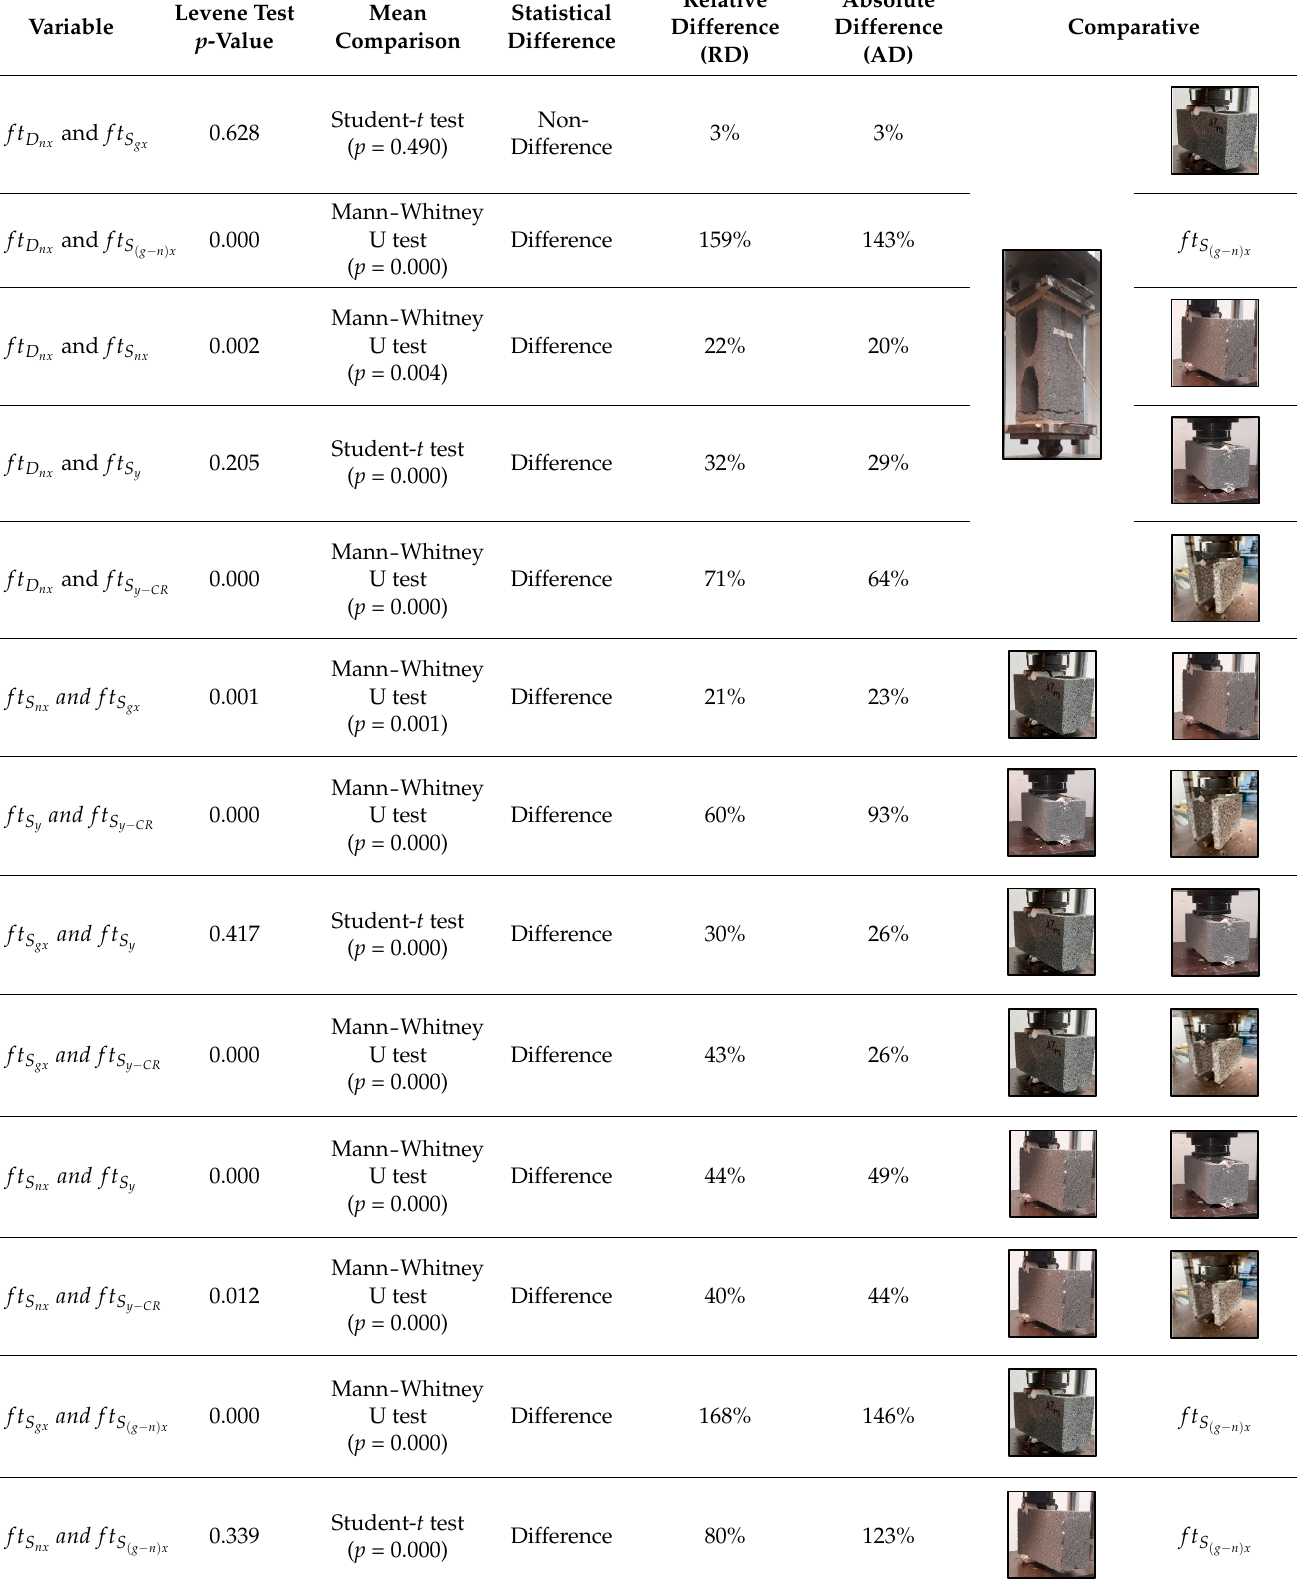
Table 3. Results from the statistic tests.